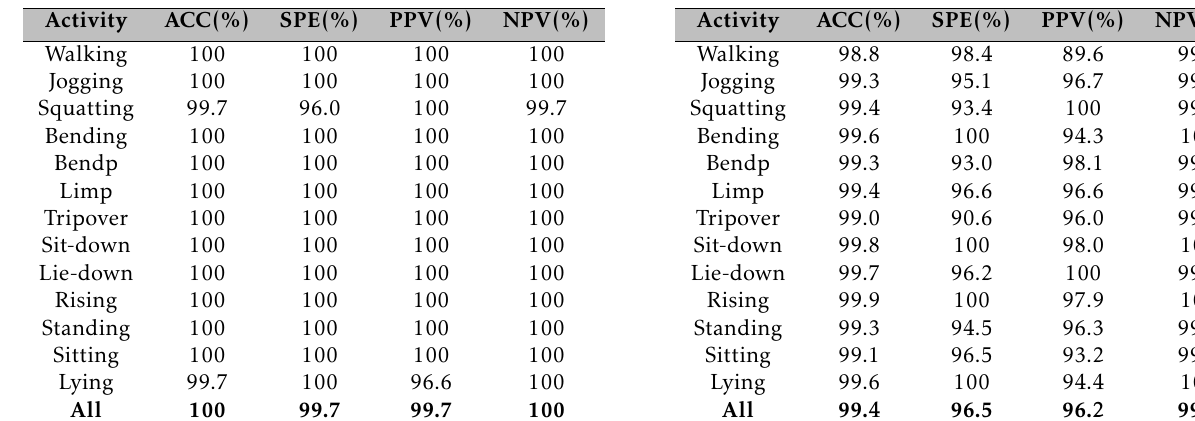
Tab 6. Result of applying the RF on the private dataset. Tab 7. Evaluation of experimental